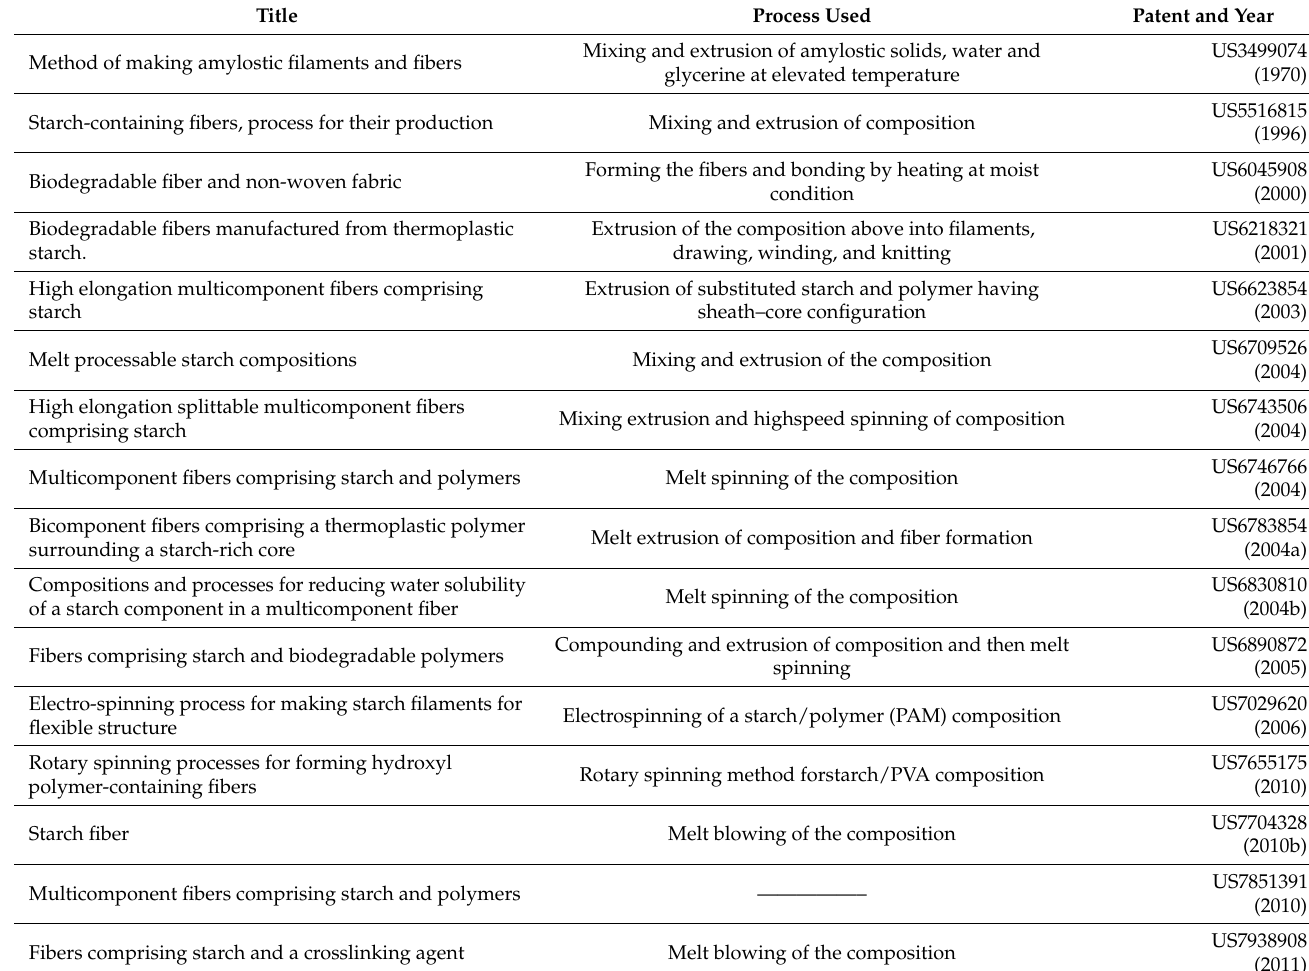
Table 1. Fiber spinning from thermoplastic starch composition (TPSC)